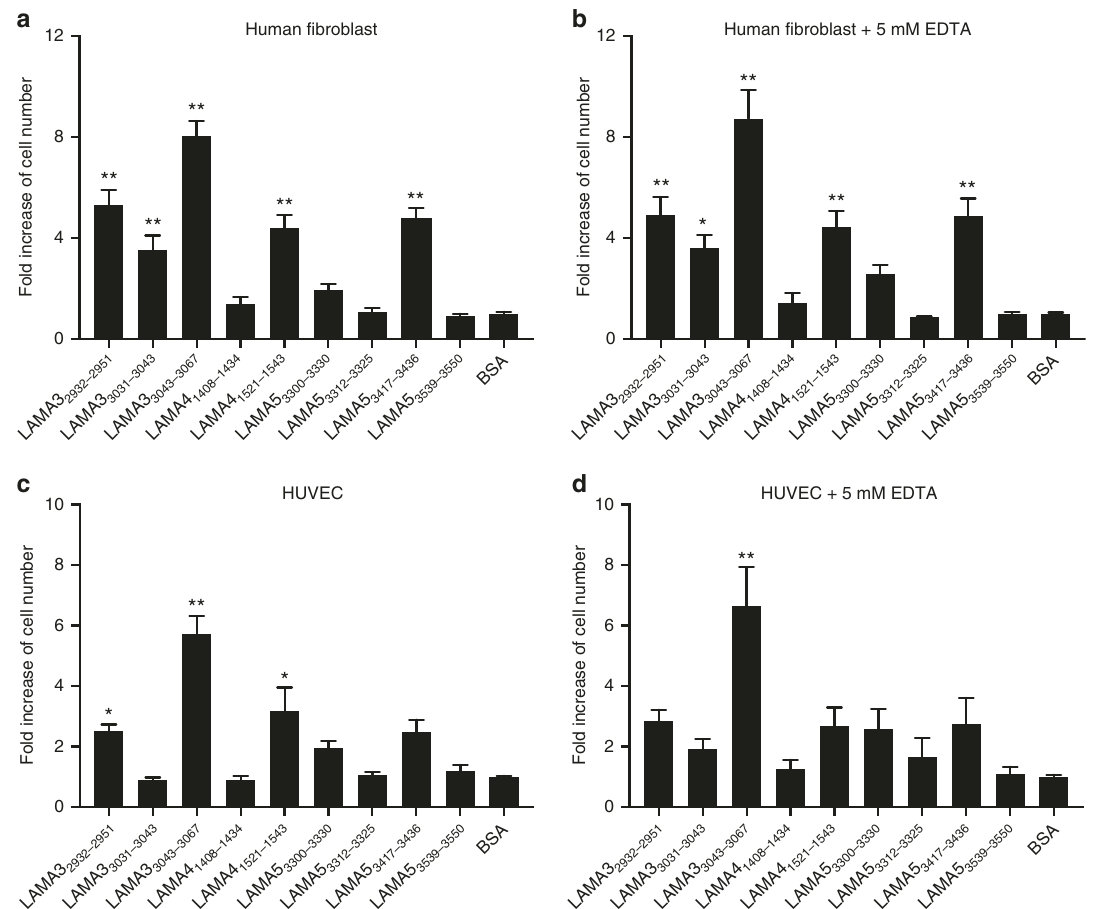
Fig. 6 Laminin HBD peptides promote cell adhesion in vitro. a , b A total of 3000 cells/well human lung fi broblasts were cultured a without or b with 5 mM EDTA in FGM-2 culture media containing 1% FBS. c , d A total of 3000 cells/well HUVEC were cultured c without or d with 5 mM EDTA in EBM-2 culture media containing 100 ng/mL VEGF-A165 and 1% FBS. Cells were plated on 1 μ g/mL laminin peptide pre-coated non-tissue culture-treated plates and incubated for 30 min at 37 °C. After plate washes, cell numbers were quanti fi ed using a CyQUANT assay ( n = 10, mean ± SEM). The signals obtained from BSA-coated wells are normalized to 1, and relative fold increases of cell numbers were calculated. Statistical analyses were performed using ANOVA